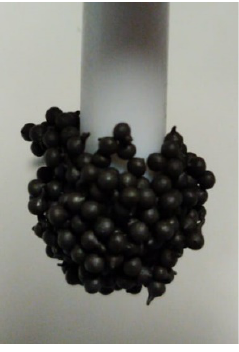
Figure 13. Capsule magnetism.